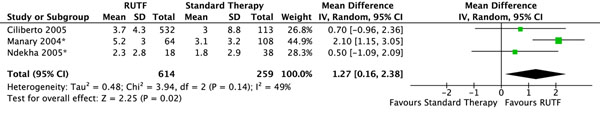
Forest plot for the effect of RUTF vs. standard therapy on weight gain in SAM